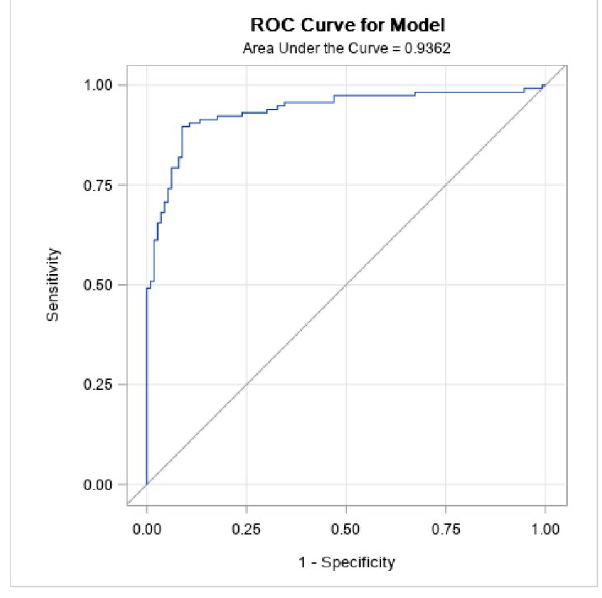
Figure 1. ROC and area under the curve (AUC) from the model. Table 3. Partial logistic regression output of receiver operating characteristic (ROC) model for cutoff value calculation.